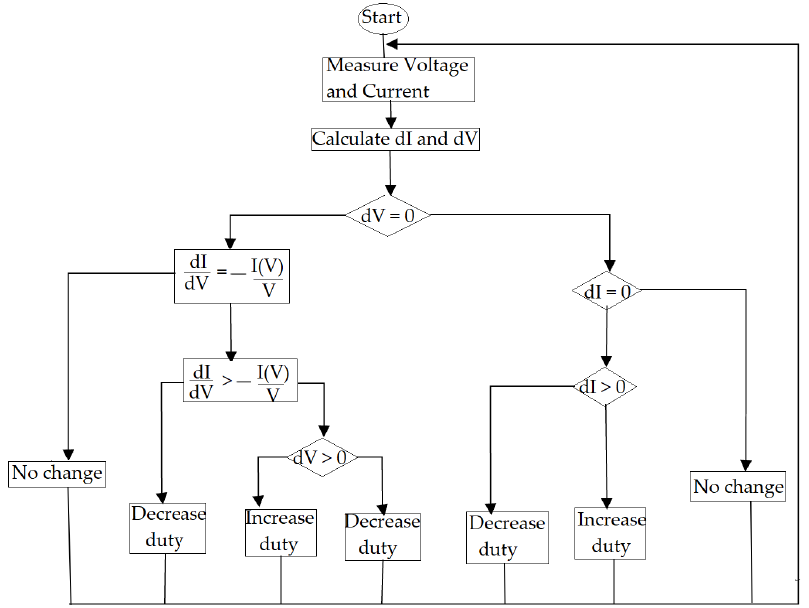
Figure 3. Flowchart of incremental conductance.